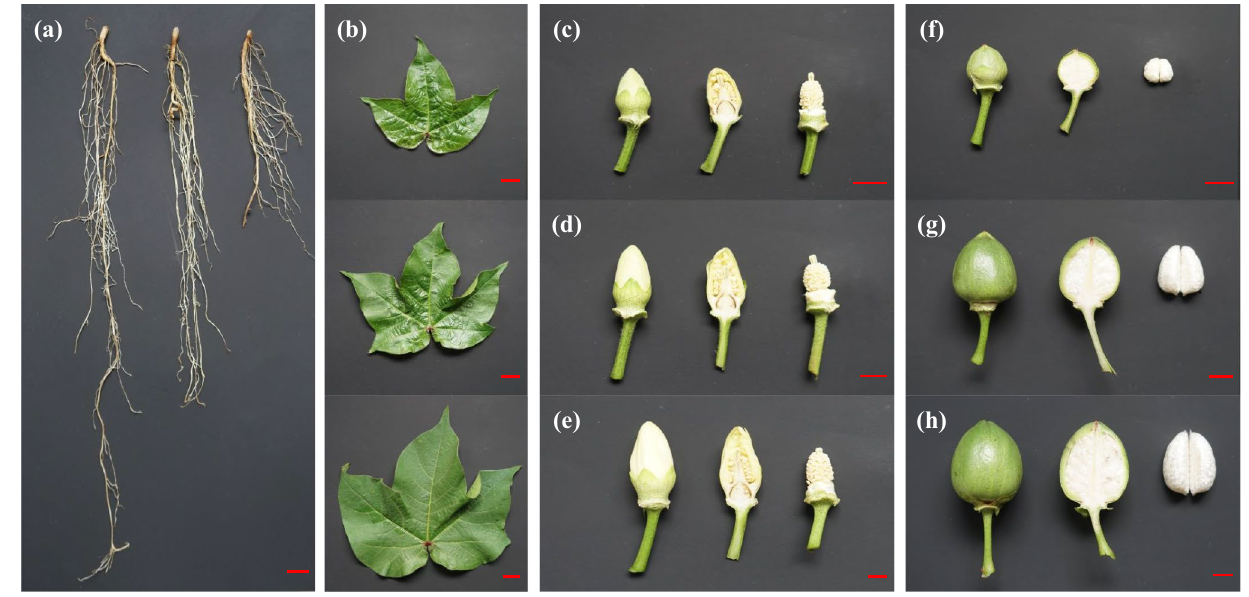
Figure 1. Seven different tissues of upland cotton Coker 312 were sampled. ( a , b ): Samples of roots and leaves were collected at 15, 25 and 35 days after germination; ( c – e ): samples of anthers and stigmas were collected